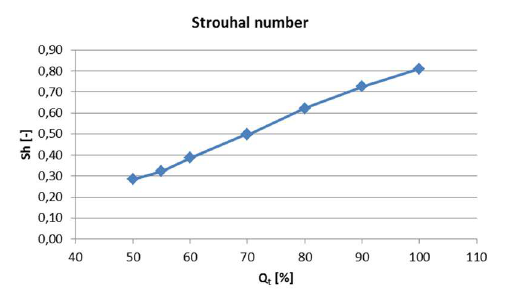
Fig. 8. Strouhal number dependency on used tangential fraction of the mass flow rate